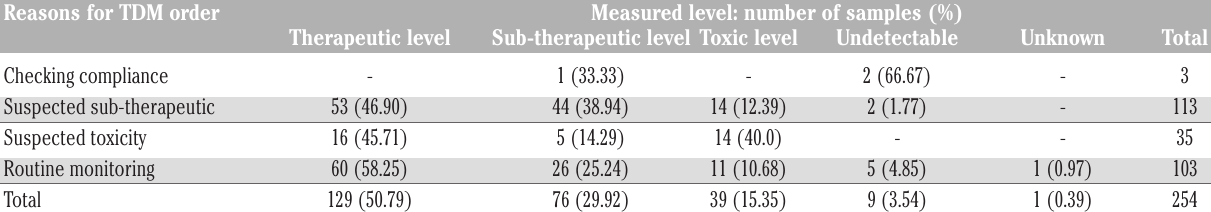
Table 4. Association between reasons for therapeutic drug monitoring order and measured drug levels. Reasons for TDM